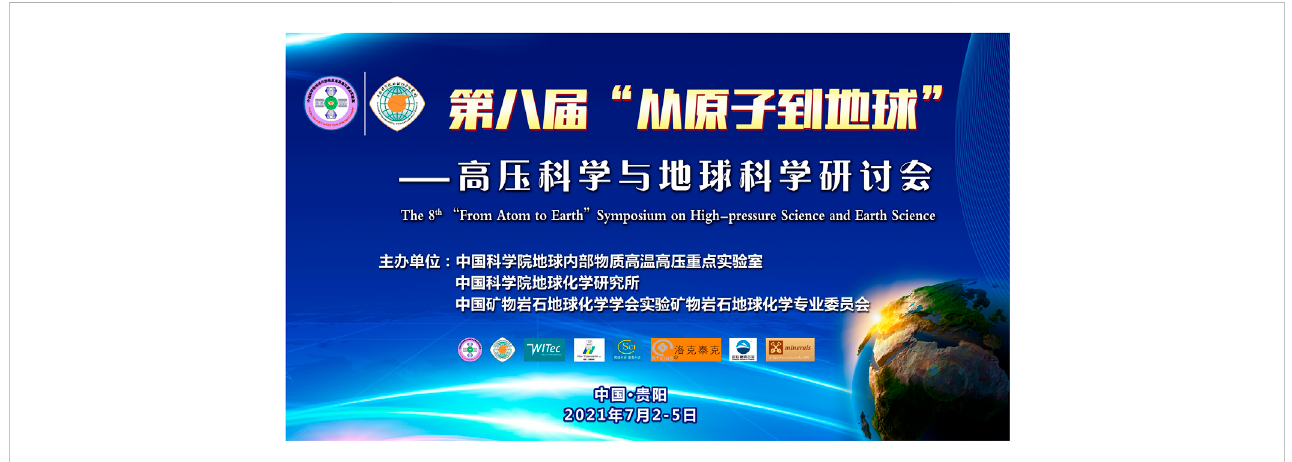
FIGURE 1 The 8th “ From Atom to Earth ” Symposium on High-Pressure Science and Earth Science held in IGCAS, Guiyang, China between July 2nd and 5th,